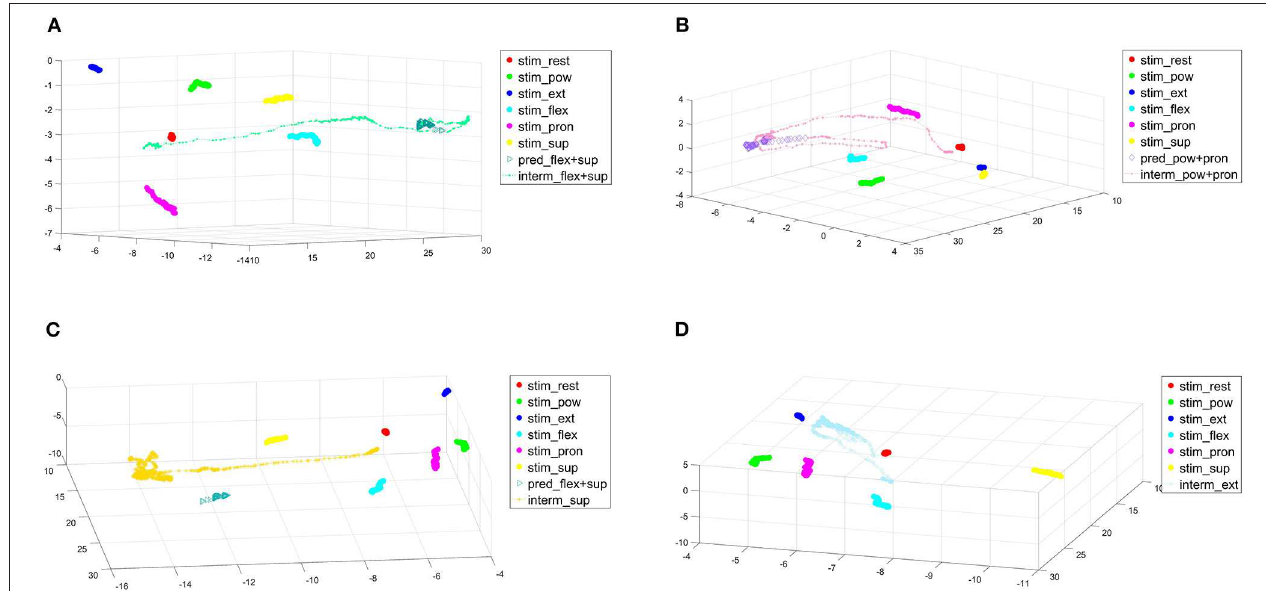
FIGURE 12 | PCA of some actions (failed or non-reachable) performed by the amputee during the first repetition. Legend items starting with “stim,” “pred,” and “interm” represent respectively the trained action clusters, the samples when the subject is in the target and the intermediate values while trying to reach the target. (A) PCA with emphasis on failed flex.+sup. for RR, (B) PCA with emphasis on failed pow.+pron. for RR-ROIG, (C) PCA with emphasis on non-reachable supination action for RR, and (D) PCA with emphasis on non-reachable extension action for